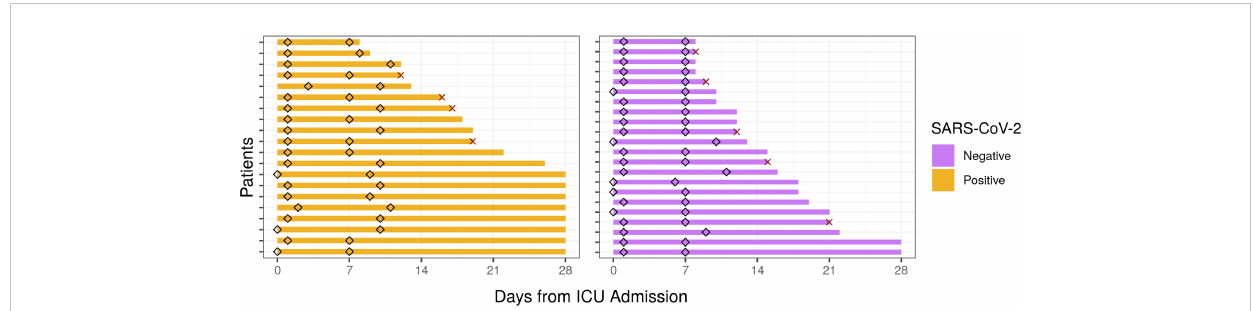
FIGURE 1 Sampling times and hospitalization duration of ICU patients from the COLOBILI cohort. Diamonds indicate time of sampling for each patient, with the majority of D1 samples collected at Day 1 in the ICU, and D7 samples at Day 7 in the ICU. The solid bars represent the duration of hospital stay (cutoff at 28 days post-ICU admission). X indicates death in the